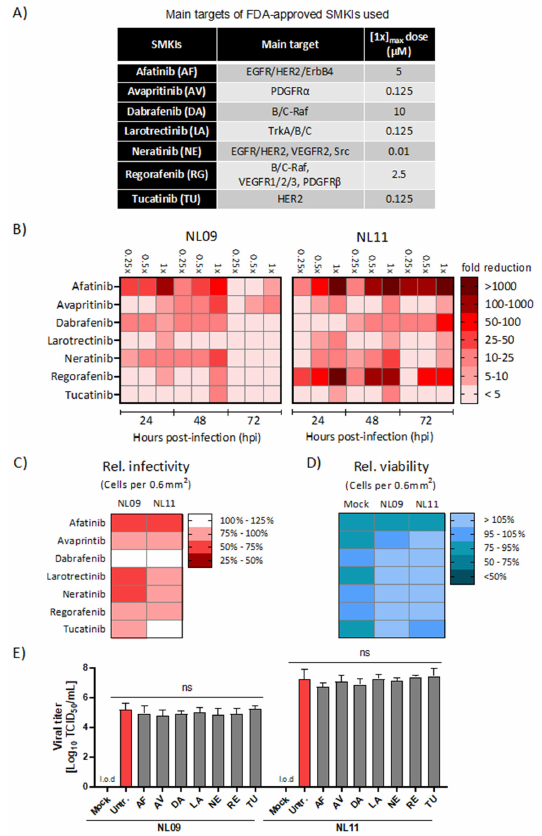
Figure 1. Effect of SMKI treatment on IAV replication, infectivity and viability. ( A ) Main targets and applied dosages of FDA-approved SMKIs used in this study. ( B ) A549 cells were infected with NL09 or NL11 at MOI = 1 +/ − the indicated SMKIs at [0.25 × , 0.5 × or 1 × ] max concentration up to 72 hpi. Viral titers were quantified by a TCID 50 /mL assay at 24, 48 and 72 hpi and visualized using a heatmap of the fold-change in viral titers relative to DMSO treatment ( n = 4/condition). Additionally, see Figure S2. ( C , D ) A549 cells were infected with NL09 or NL11 at MOI = 1 and incubated for 48 h in the presence of SMKIs ([0.5 × ] max concentration). Fluorescence microscopy images were acquired from cells stained for infected cells by anti-IAV NP antibody (red), and nuclei by using NucBlue Live ReadyProbes (blue). Data visualized in the heatmap are % infectivity ( C ) and % cell viability ( D ) relative to untreated infected cells or mock-infected treated cells ( n = 4/condition). Additionally, see Figure S3. Images were quantified using ImageJ software. ( E ) NL09 and NL11 virus stocks were preincubated with the control (DMSO) or the [1 × ] max concentration of the respective SMKI for 4 h at 37 ◦ C. A549 cells were then infected using a 1:1000 dilution. Viral titers were determined at 72 h by a TCID 50 /mL assay ( n = 3). Means ± SDs are shown. l.o.d.: limit of detection. ns, not significant. p -values were determined by Welch t-tests compared to untreated